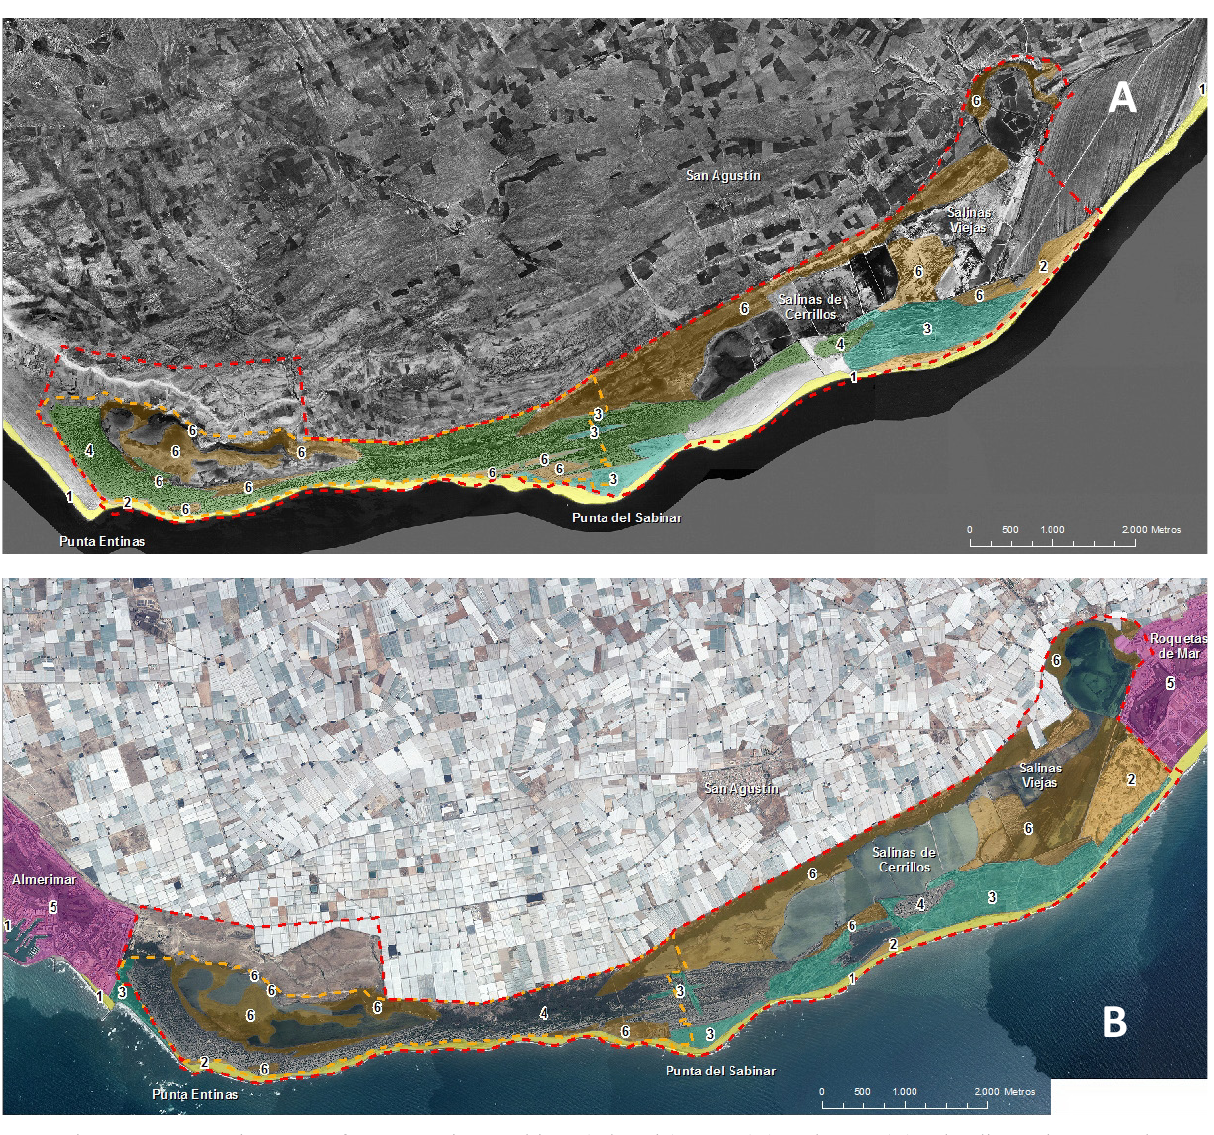
Figure 4. Vegetation map of Punta Entinas-Sabinar (Almeria) 1956 (A) and 2013 (B). The discontinuous red lines indicate the protected natural space, the yellow lines the natural reserve. 1, Beach and the halo-nitrophilous communities; 2, Mobile dunes; 3, Semi-fixed dunes; 4, Stable dunes; 5, Urbanizations; 6, Salt marsh